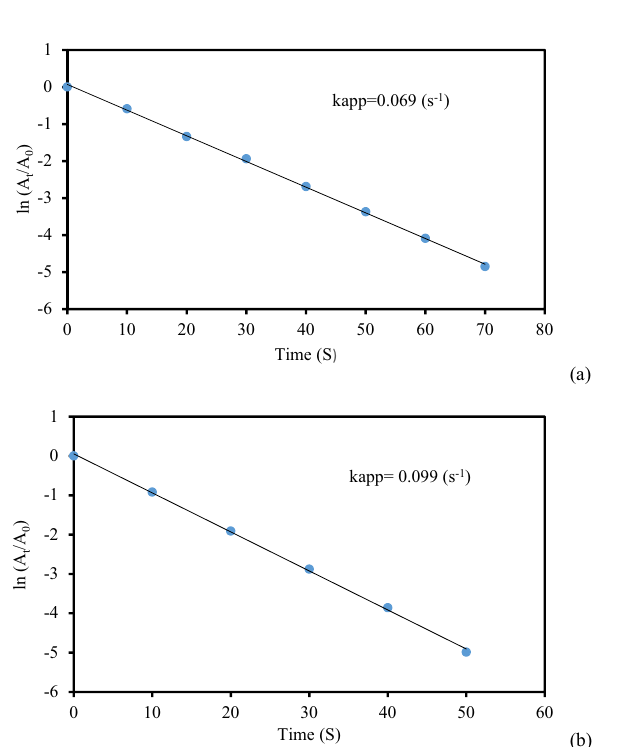
Figure 12. The kinetic plots (lnA t /A 0 vs t) for the reduction of MO using ( a ) 2 mg and ( b ) 3 mg of KIT-5- biguanidine-Au(0)